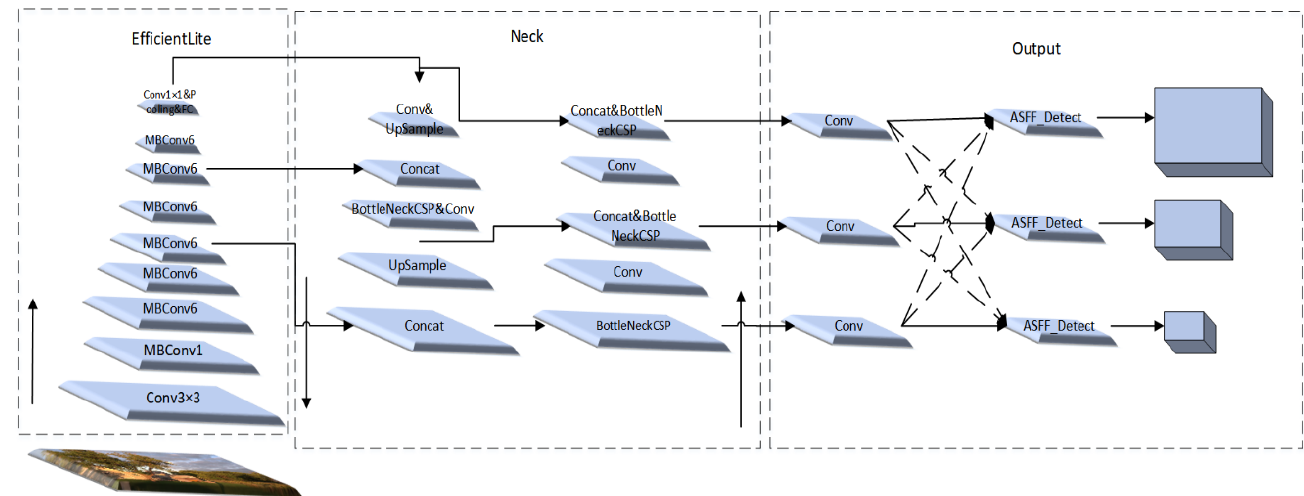
Figure 5. The internal structure of improved Yolov5.